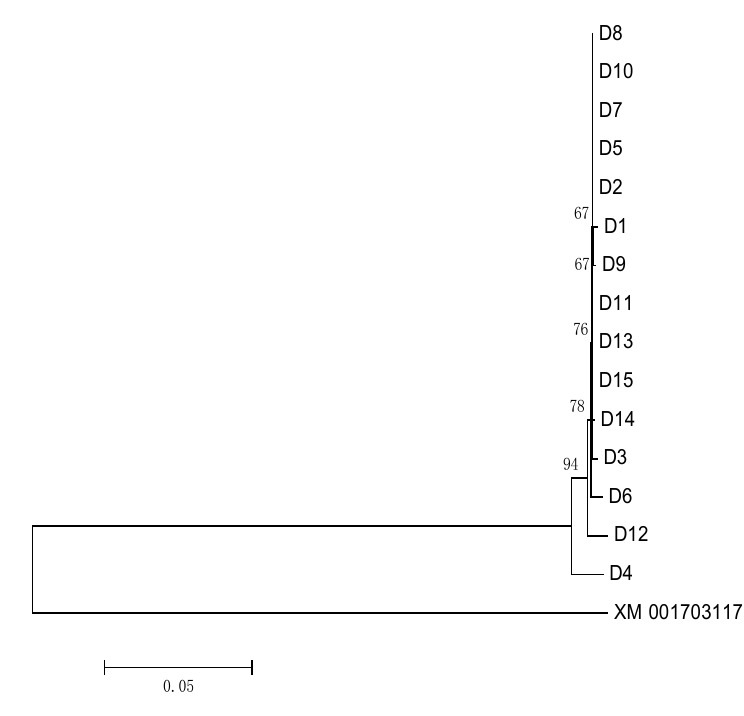
Figure 8. GGPS phylogenetic tree of the 15 Dunaliella species based on the neighbor-joining algo- rithm.